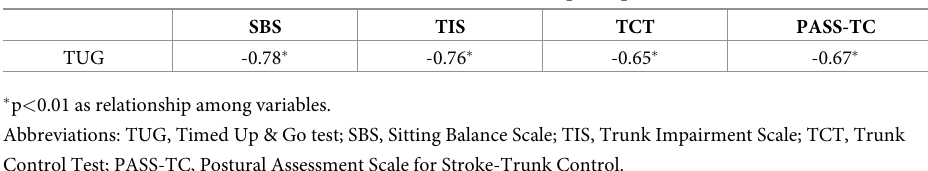
Table 2. Correlation between TUG and SBS, TIS, TCT, PASS-TC in participants.